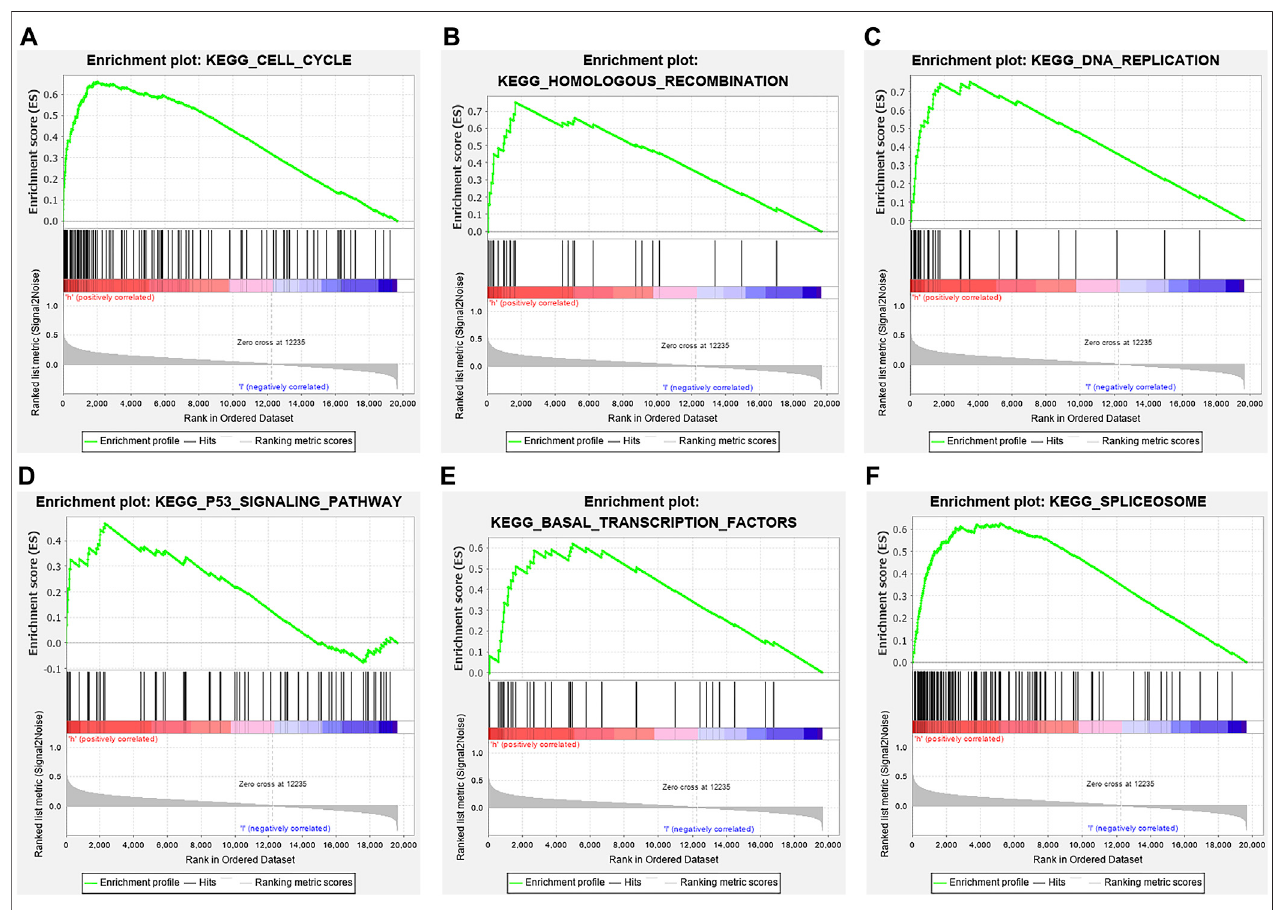
FIGURE8| ESCA-relatedsignalingpathwaysenrichedinthehigh-SPDL1expressiongroupviaGSEA. (A) Cellcycle; (B) HR; (C) DNAreplication; (D) p53signaling pathway; (E) basaltranscription factor; and (F) spliceosome. GSEA,gene setenrichmentanalysis; HR,homologousrecombination; ESCA, esophageal cancer;SPDL1, spindle apparatus coiled-coil protein 1.